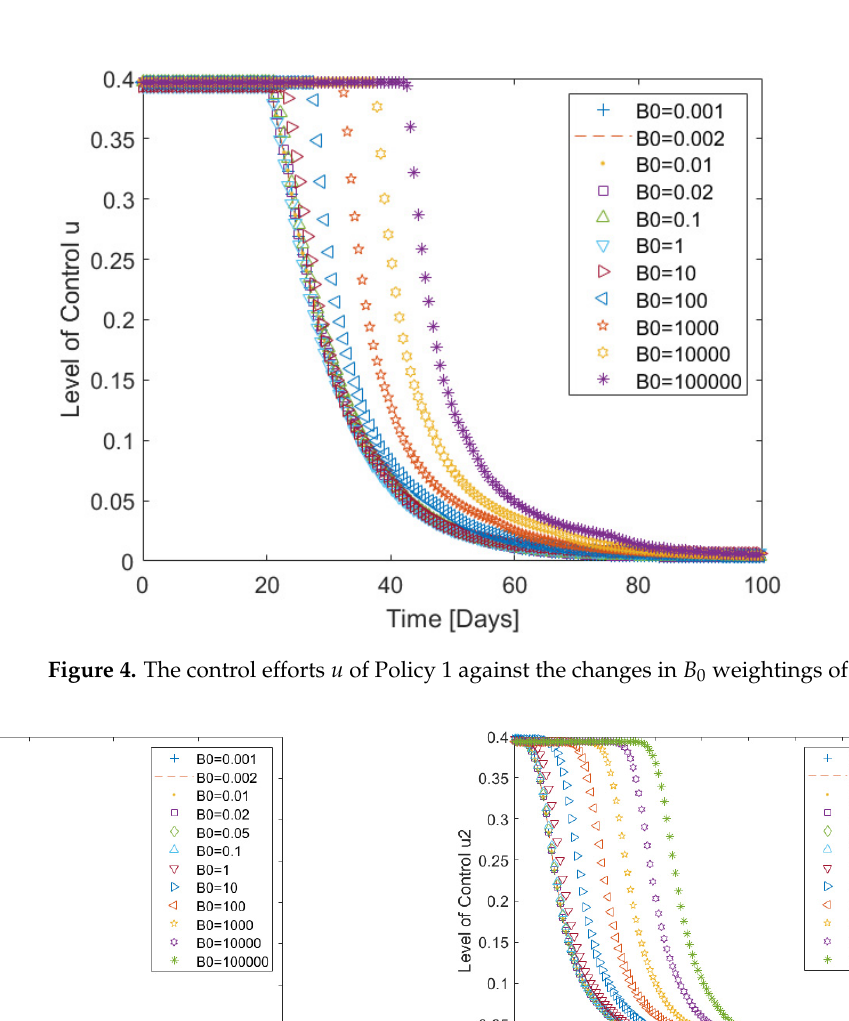
Figure 5. The control efforts u 1 and u 2 of Policy 2 against the changes in B 0 of Equation (15). ( a ) Control effort u 1 ; ( b ) Control effort u 2